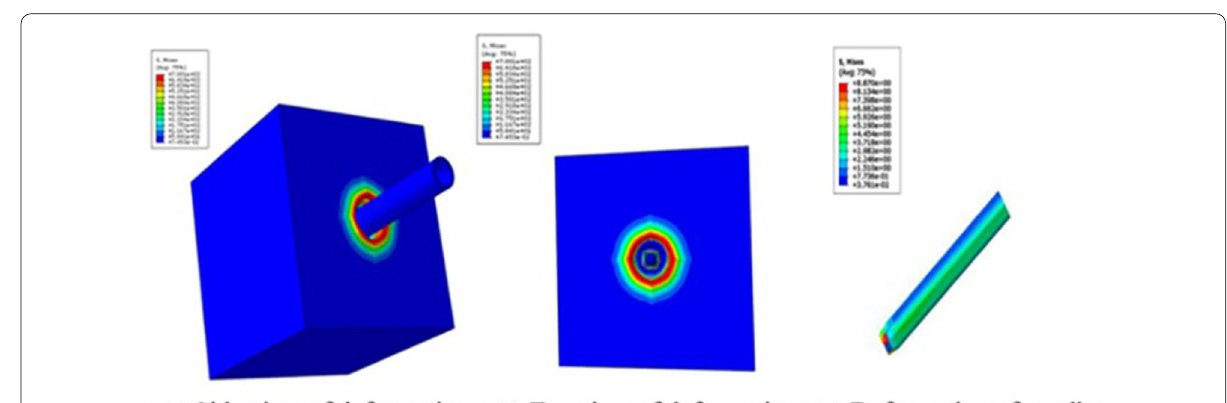
Figure 9 Nephogram of stress change during